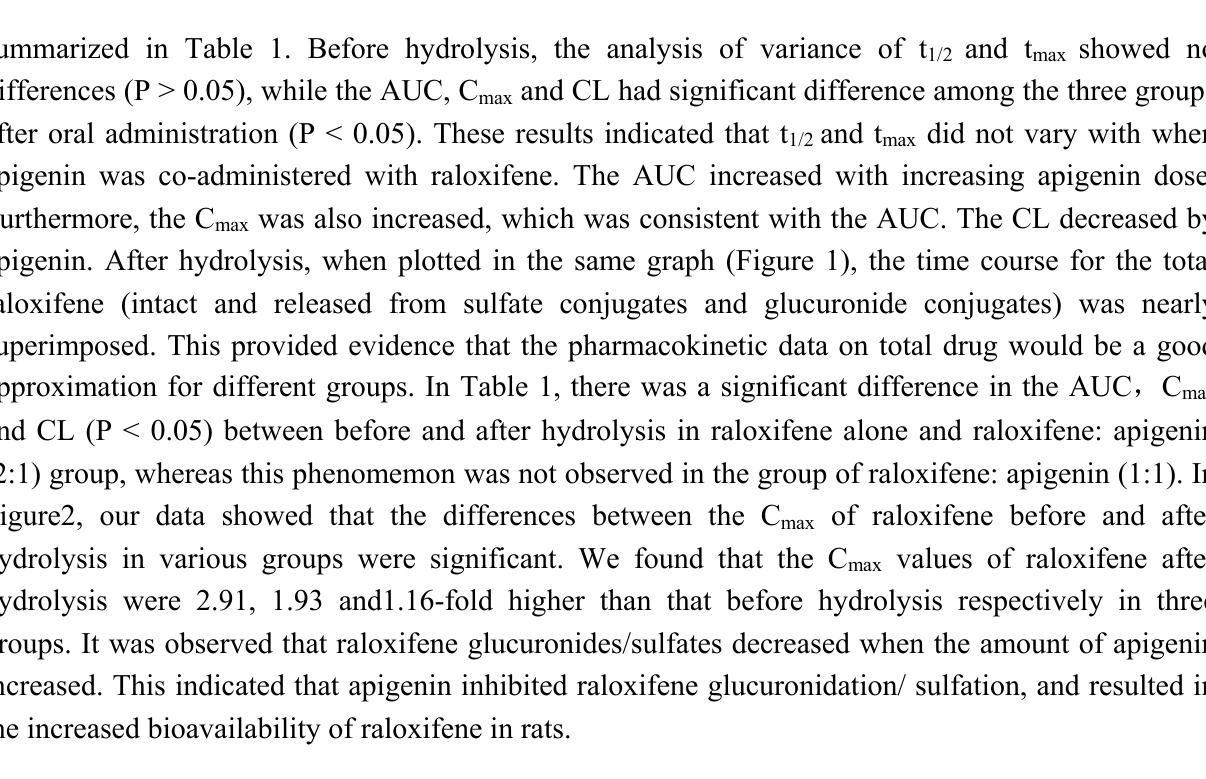
Figure 1. The rat pharmacokinetics profile of intact raloxifene of (A) before hydrolysis and (B) after hydrolysis of three groups in same graph. Each point represents the mean ± SD ( n = 5).